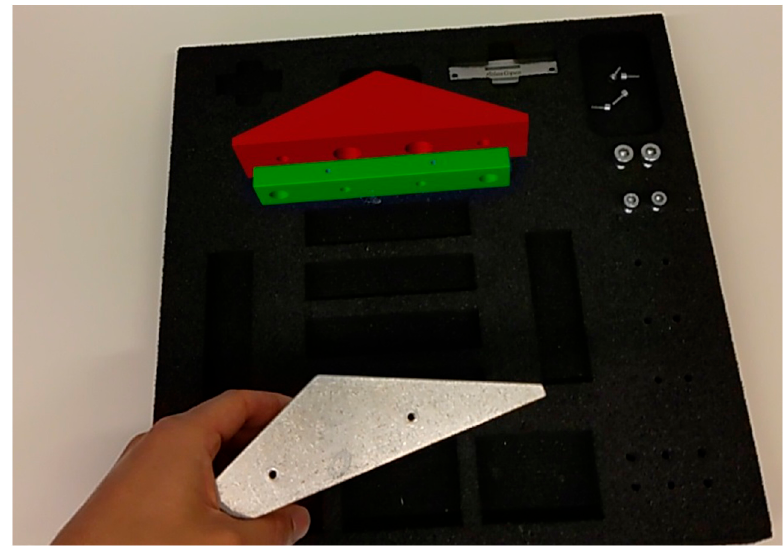
Figure 6. Component selection step; selection of the roof is incorrect (red color), the app suggests in green the correct component to be selected (banner).